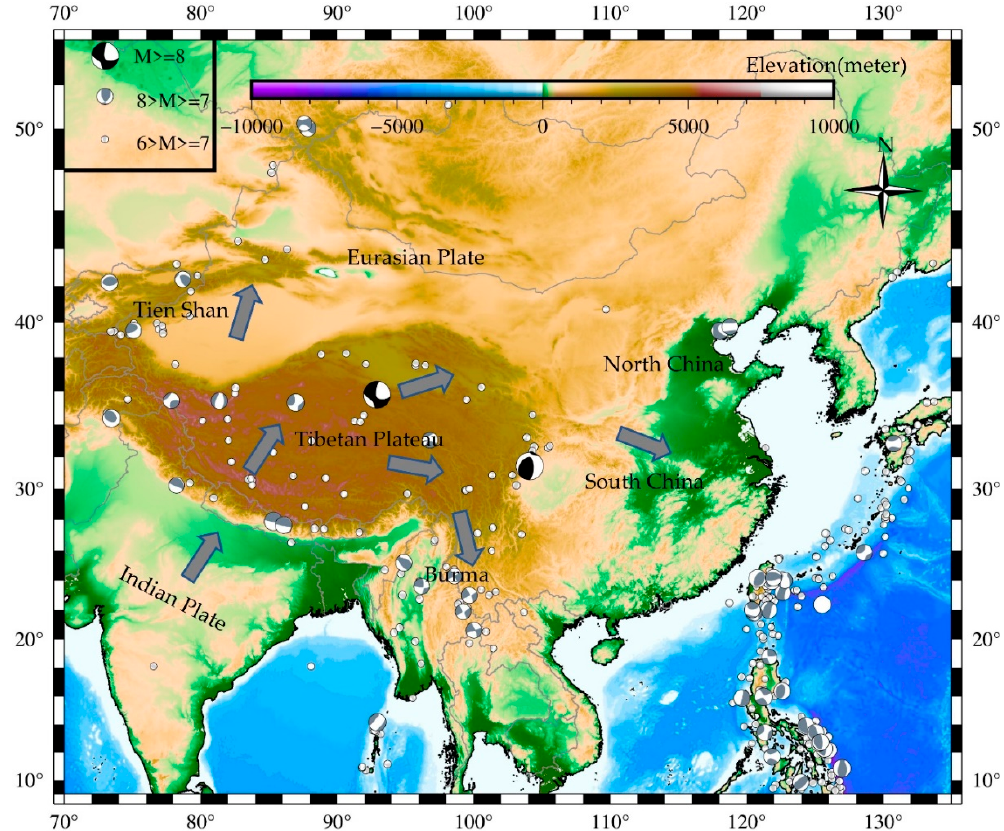
Figure 1. The distribution of earthquake in China. Black arrows indicate motion directions of the Indian plate and continental China. (the earthquake data from https://www.globalcmt.org/CMTsearch.html).